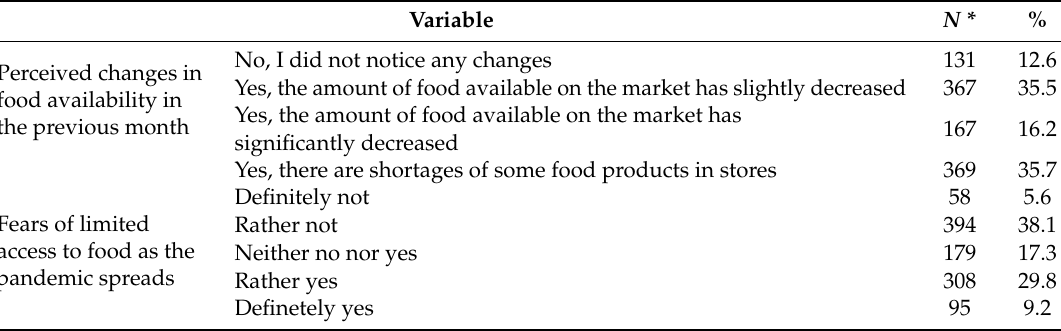
Table 4. Opinions on availability of food during the COVID-19